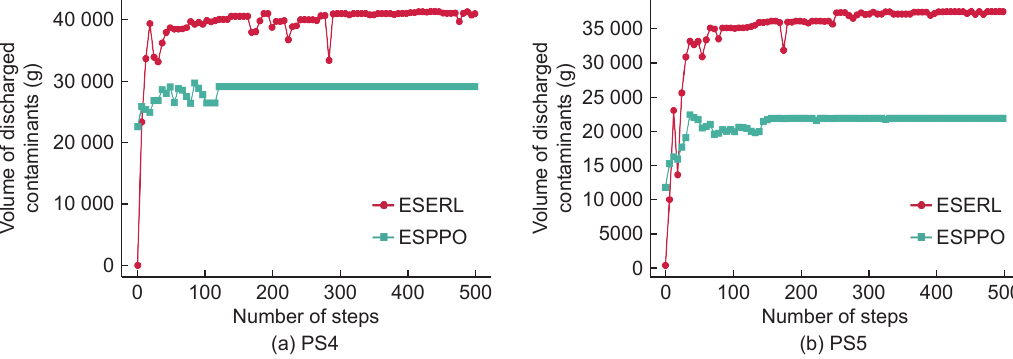
Fig. 9 Volume of discharged contaminants for multiple pollution events by ESERL and